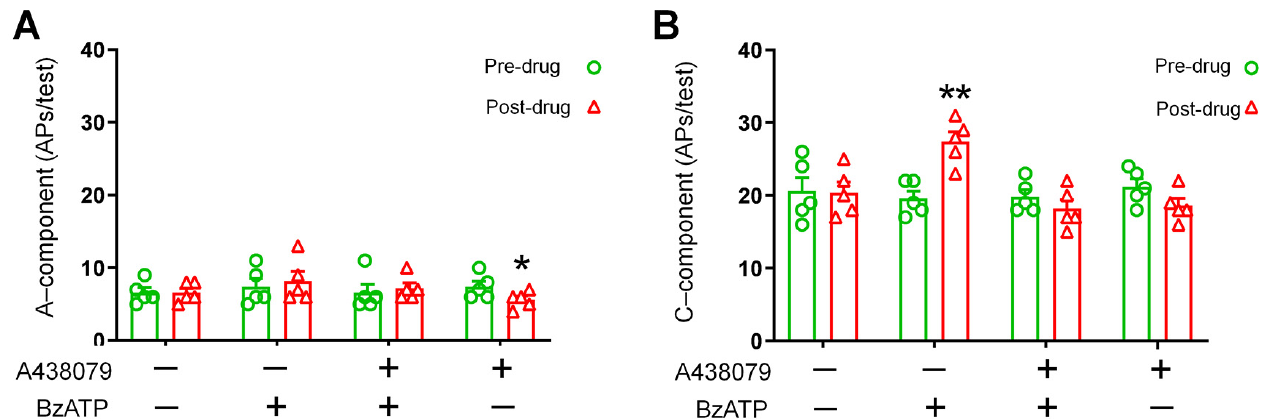
Figure 5. Effects of ganglionic BzATP application on spinal wide-dynamic-range (WDR) neuronal responses to electrical stimulation. ( A ) WDR neuron responses to supra-threshold electrical stimu-